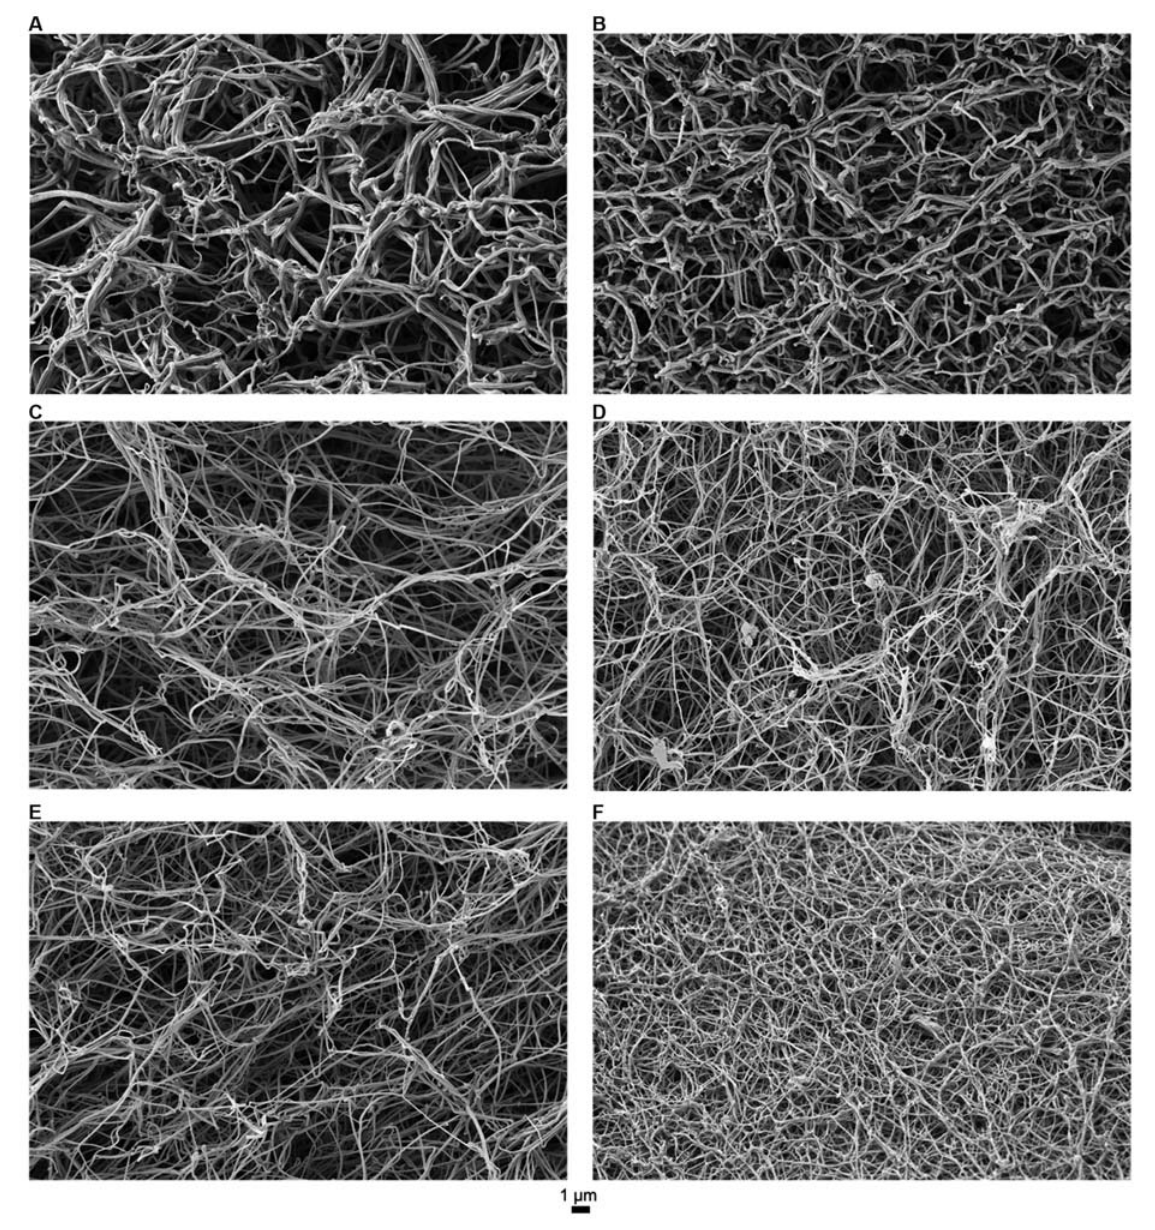
Fig. 3 Representative scanning electron microscopy images of fi brin clots. ( A ) aPCC (50 mU/mL); ( B ) aPCC (500 mU/mL); ( C ) aPCC (50 mU/mL) þ SIA (200 nM); ( D ) aPCC (500 mU/mL) þ SIA (200 nM); ( E ) aPCC (50 mU/mL) þ SIA (600 nM); ( F ) aPCC (500 mU/mL) þ SIA (600 nM). aPCC, activated prothrombin complex concentrate; SIA, sequence-identical